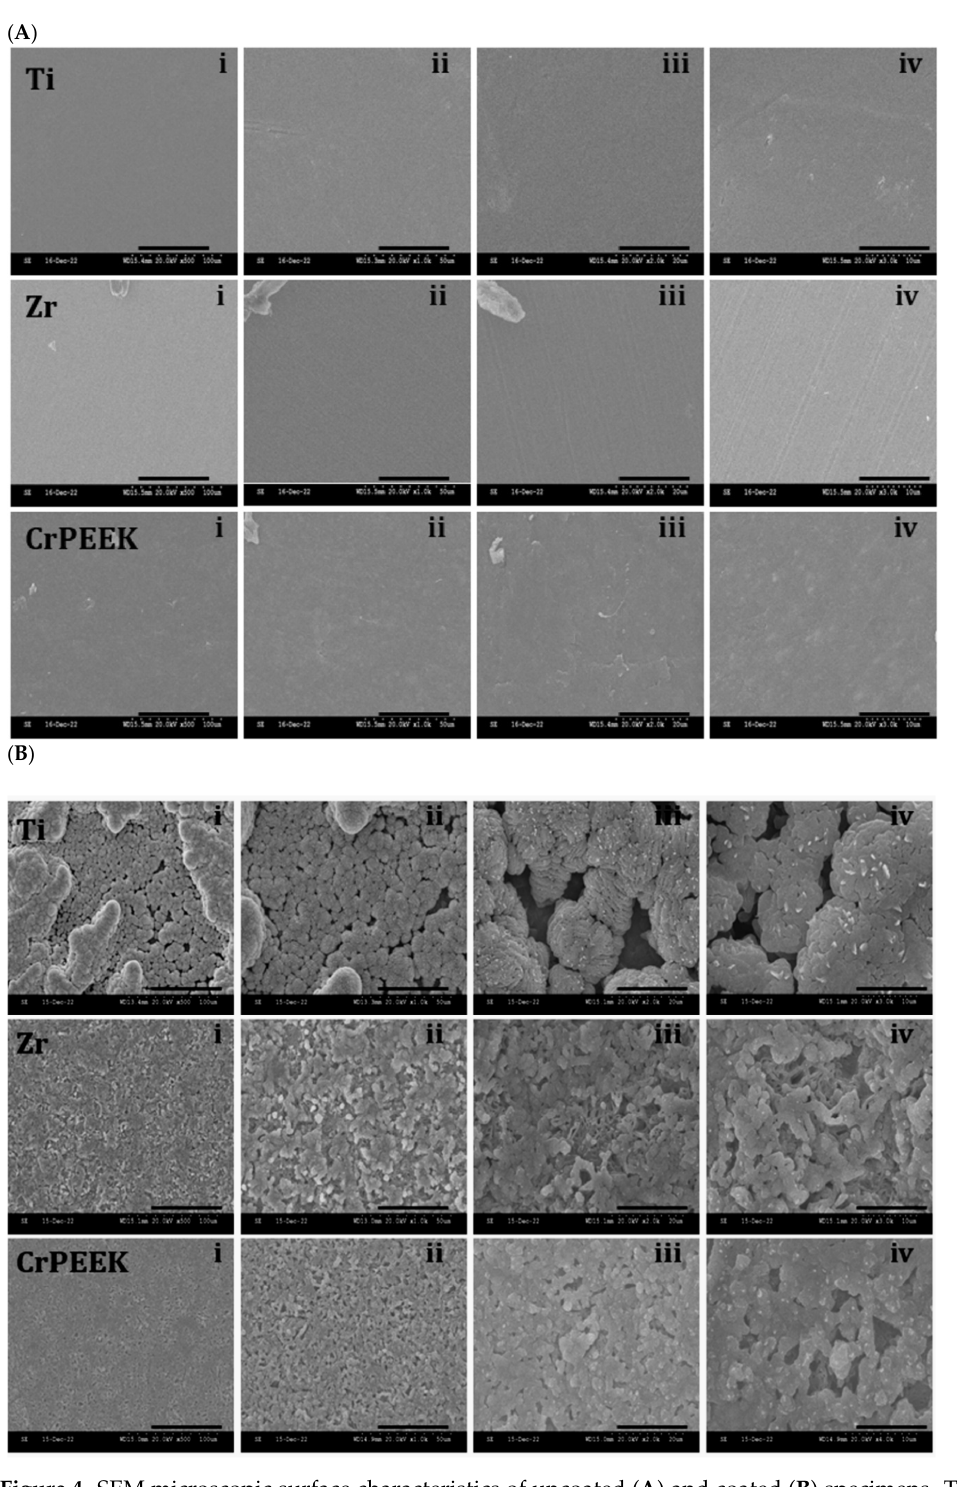
Figure 4. SEM microscopic surface characteristics of uncoated ( A ) and coated ( B ) specimens. The surface images of three specimens were captured at different magnifications: i—100; ii—50; iii—20; and iv—10 µ